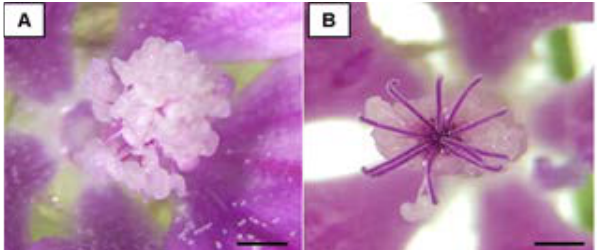
Fig. 1. Flower morphology and reproductive phases in M. sylvestris , as seen in stereomicroscope A. Male phase: The mature stamens. Note the pollen grains on petals. B. Female phase: Ten open branched mature stigma with papillate receptive surface. Bar: 1 mm (A, B)